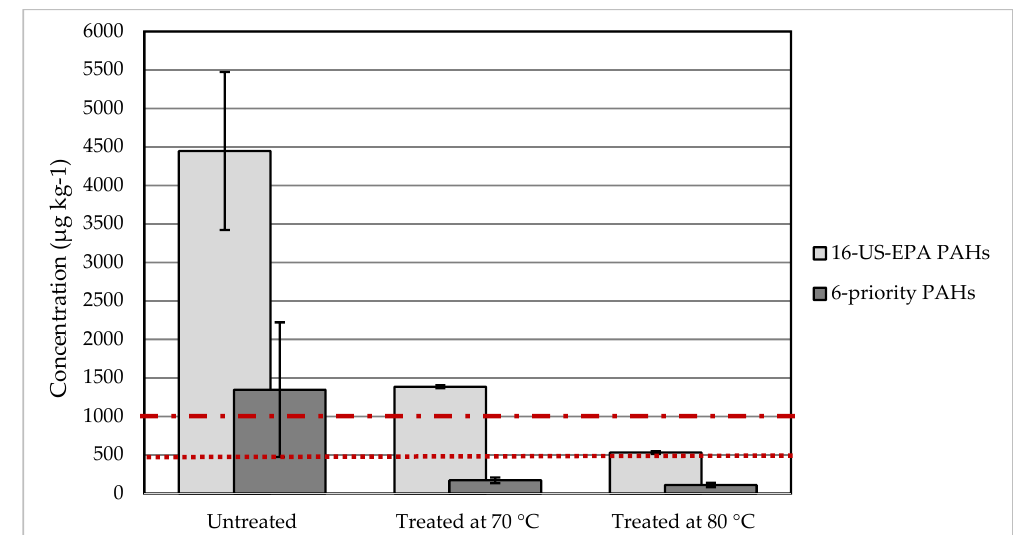
Figure 4. The sum of the 16-US-EPA polycyclic aromatic hydrocarbons (PAHs) content and the 6-priority PAHs in samples before and after pretreatment by SCE. The dotted lines represent the REACH limits for the 8 priority PAHs in consumer products (upper line) and children articles (lower line).